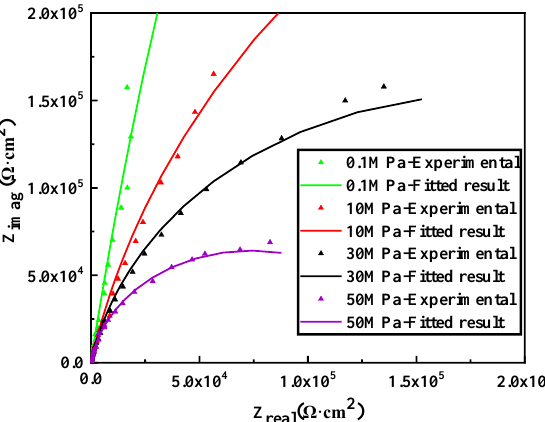
7 of 13 Figure 7. The polarization curves of TC4 alloy after 1 h charging in 3.5% NaCl solution at different HPs. Figure 8 shows the Nyquist plots for the sample charged for 1 h under different HPs